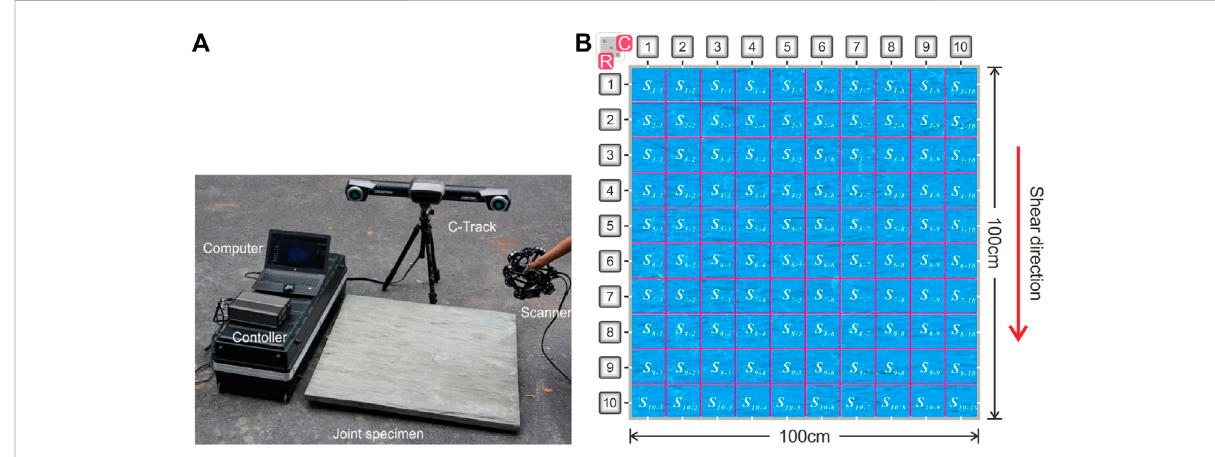
FIGURE 2 Joint surface scanning and digitization. (A) Scanning of the joint surface (Du et al., 2022); (B) Digitized joint surfaces of specimens with sizes of 100 mm 2 × 100 mm 2